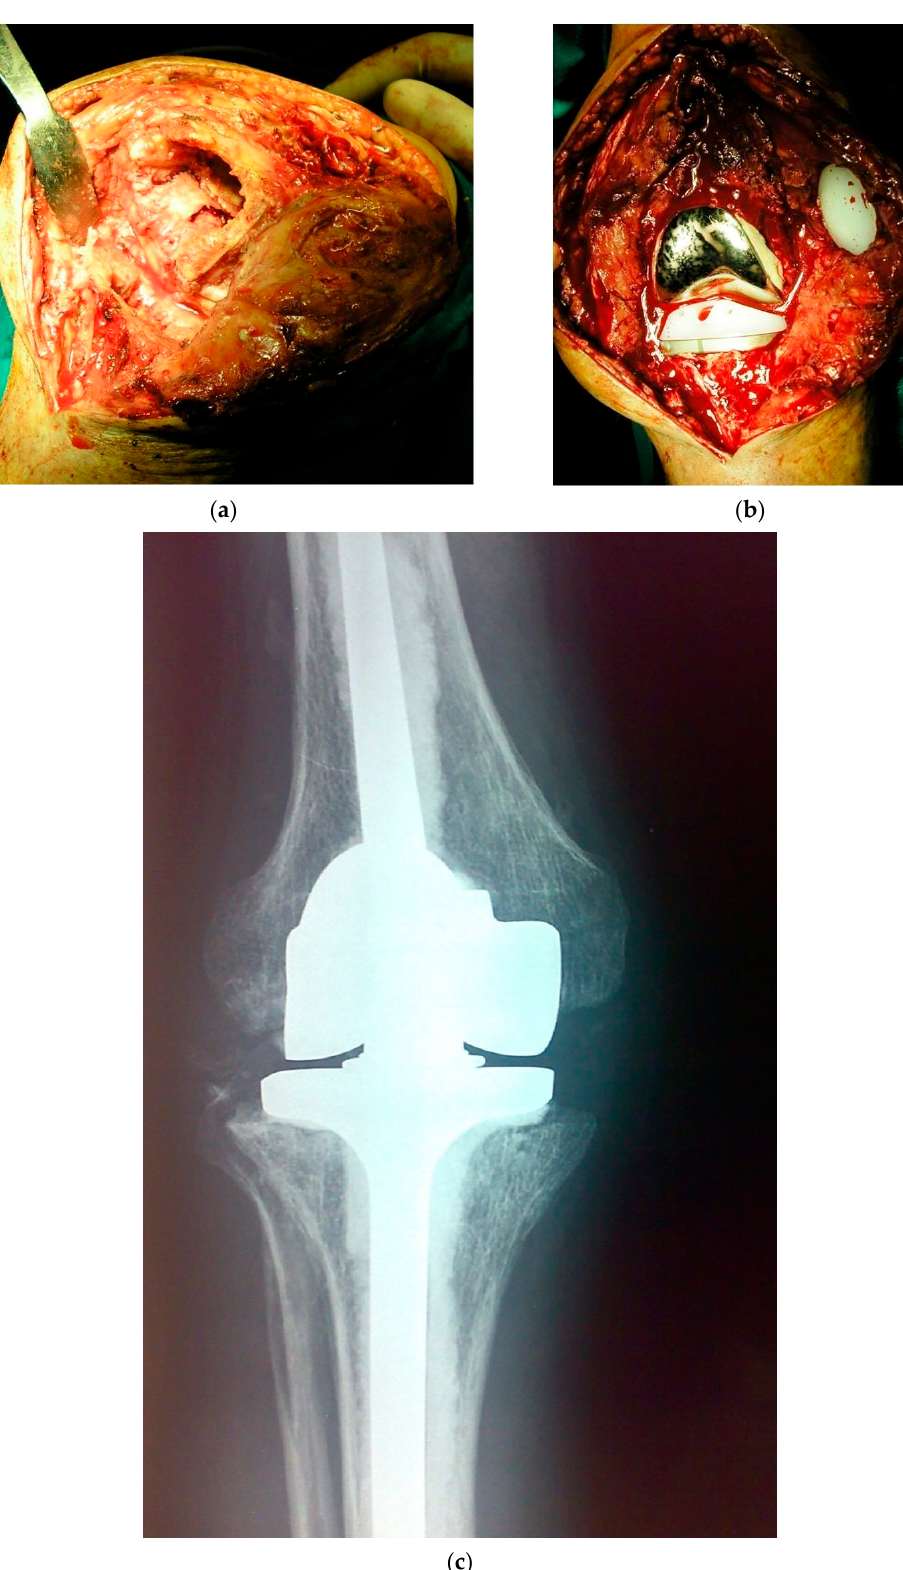
Figure 3. ( a – c ). Images of the same patient of Figures 1 and 2 relative to the second stage of the two-stage revision arthroplasty: ( a ) Intraoperative image after removal of the articulated spacer; ( b ) Intraoperative image with the new prosthesis implanted; ( c ) Postoperative radiograph of the implanted prosthesis (rotating hinge total knee arthroplasty).